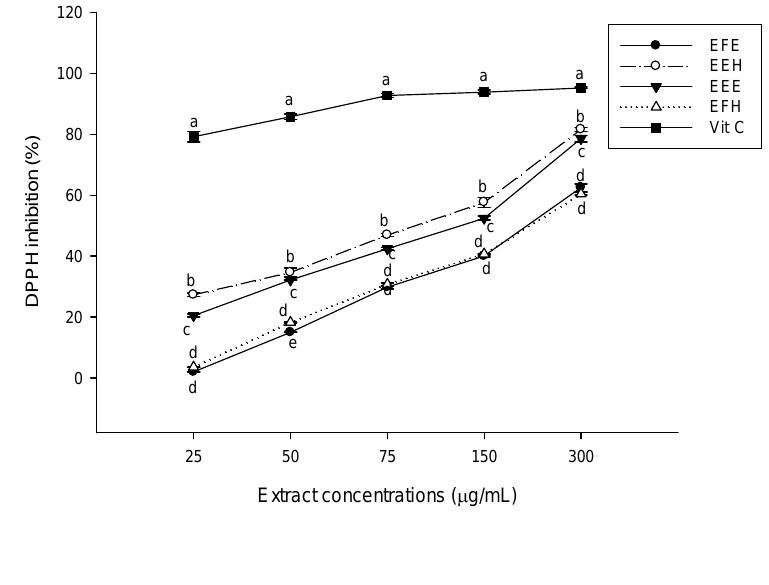
Figure 1. 2,2-diphenyl-1-picrylhydrazyl (DPPH) scavenging potential of the different plant extracts. Values are expressed as mean ± standard deviation (SD) of three replicates. In the same concentration the values affected with different letter are significantly different at p < 0.05. EEE: H. zenkeri ( bark) ethanolic extract; EFE: H. zenkeri (leaves) ethanolic